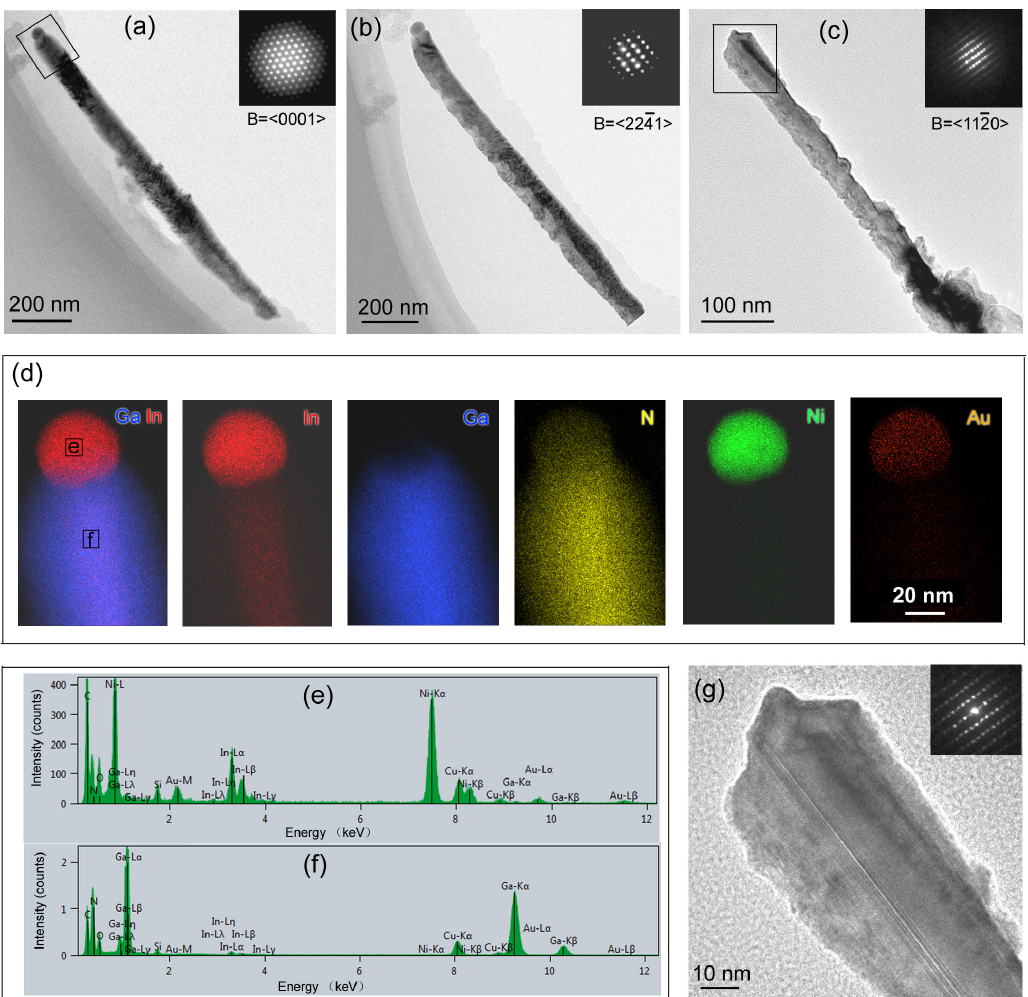
Figure 6. ( a – c ) BF TEM images and the corresponding CBED patterns (insets) of the In x Ga 1−x N NWs